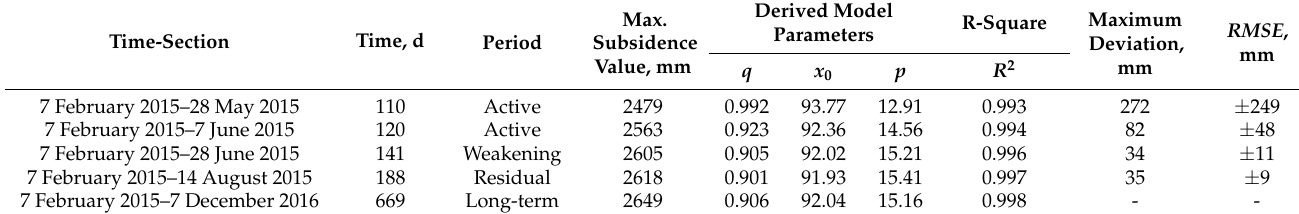
Table 1. The influence of amount of observation data on model parameters derived and predictive precision of residual surface subsidence for different time-section: q is the coefficient of surface subsidence; x 0 and p are parameters associated with the lithology of overlying strata; R 2 is the coefficient of determination.